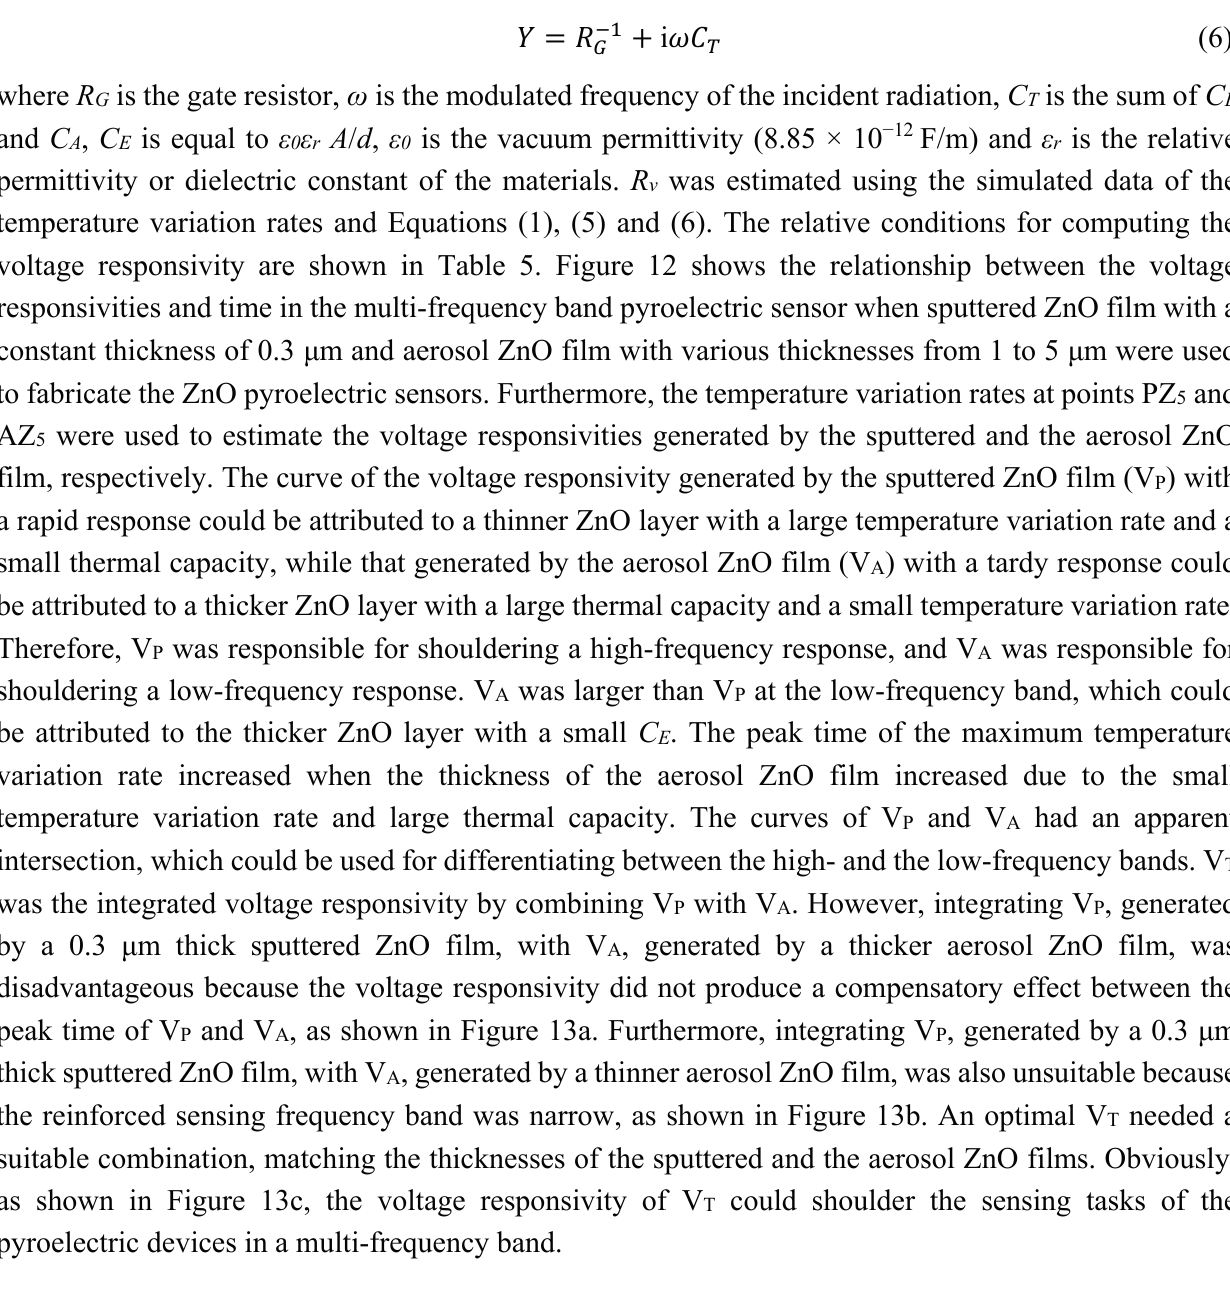
Table 5. Relative conditions for estimating Rv